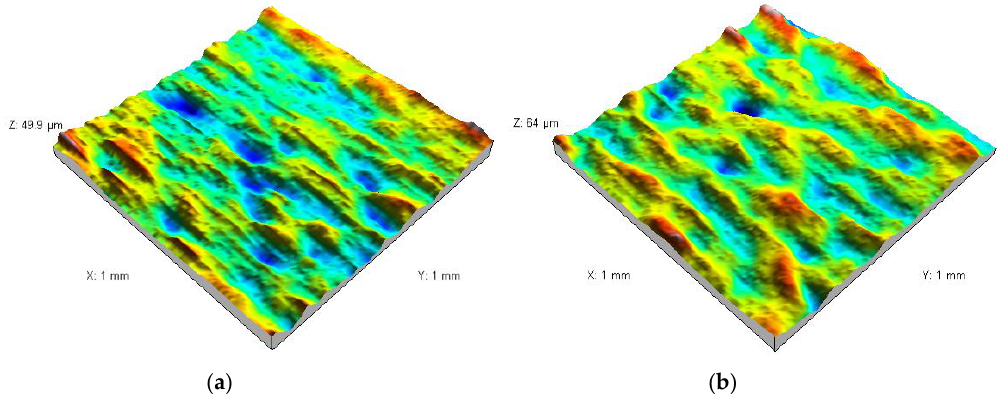
Figure 6. The surface of the reference material (PE) ( a ) and material covered with biofilm ( b ).